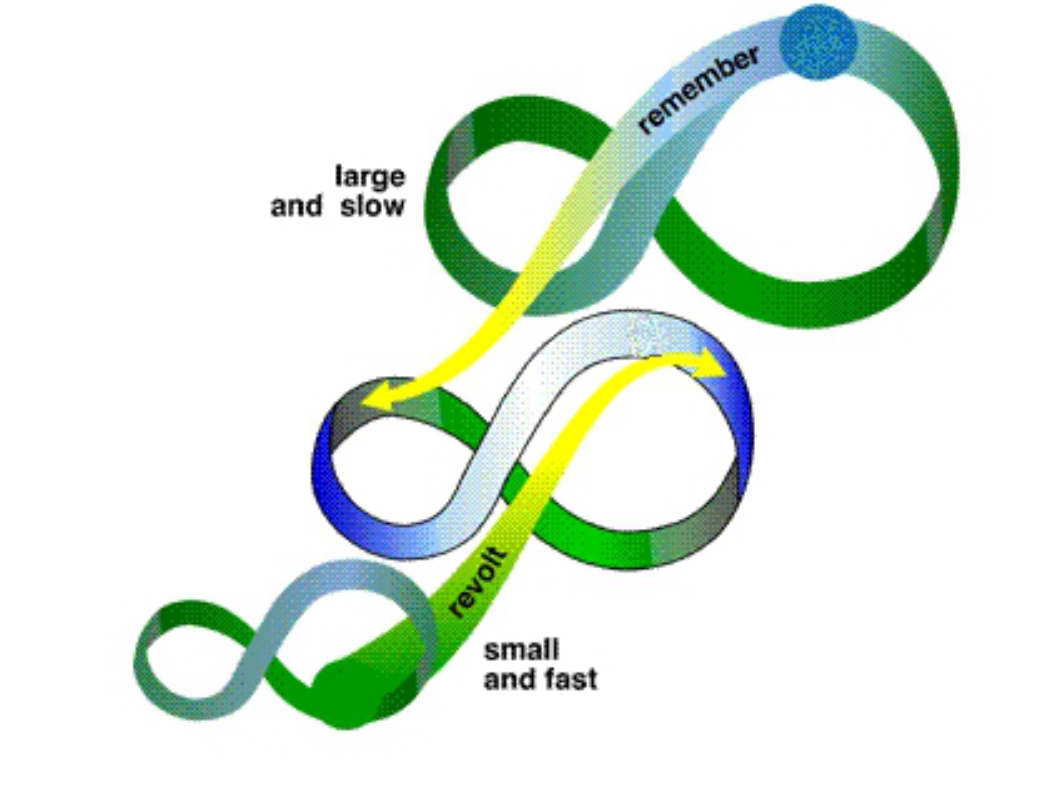
Fig. 1. Nested adaptive cycles (Folke 2006, after Gunderson and Holling